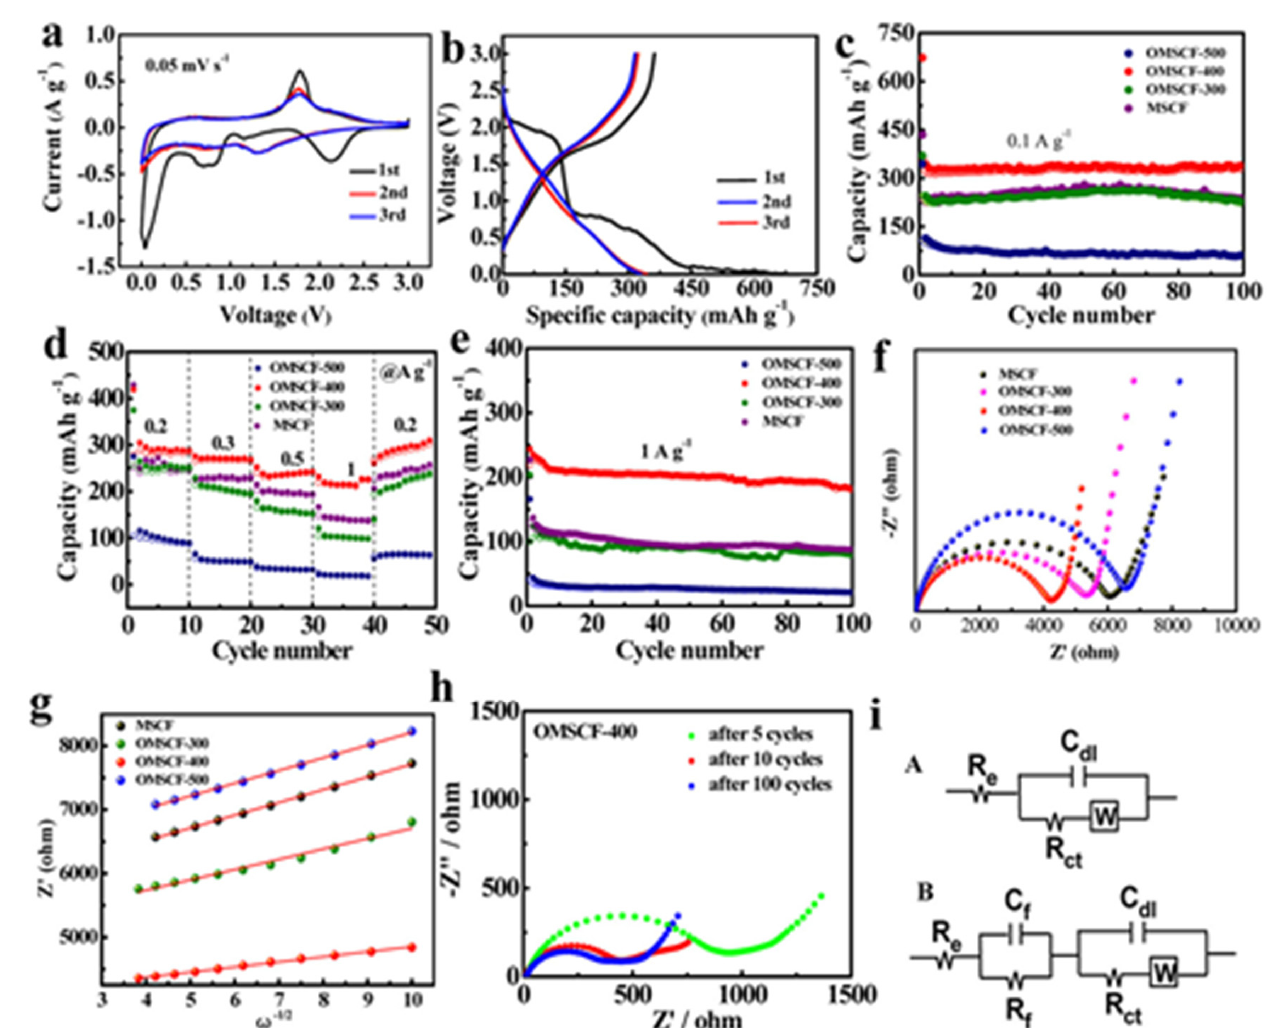
Figure 8. ( a ) CV curves of the OMSCF-400 electrode at 0.05 mV s –1 . ( b ) Galvanostatic discharge– charge profiles of OMSCF-400 for the first three cycles at 0.1 A g –1 . Cycling performance of MSCF, OMSCF-300, OMSCF-400, and OMSCF-500 at ( c ) 0.1 A g –1 and ( e ) 1 A g –1 . ( d ) Rate performance of MSCF, OMSCF-300, OMSCF-400, and OMSCF-500. ( f ) EIS curves, and ( g ) the relationship between Z ′ and ω –1/2 in the low-frequency range of MSCF, OMSCF-300, OMSCF-400, and OMSCF-500. ( h ) EIS of the OMSCF-400 electrode after various cycles. All impedance measurements were made at the fully charged state. ( i ) Equivalent circuit used to describe the Na + insertion/extraction process for the electrodes (A) before and (B) after cycling. Reproduced with permission of ref. [170]. Copyright 2018. American Chemical Society.